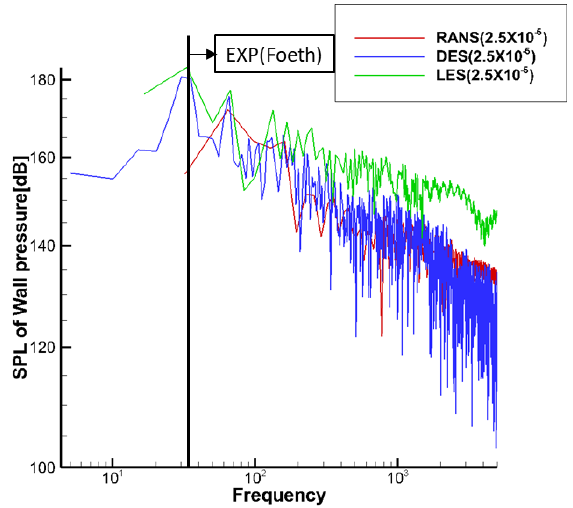
Figure 11. SPL of wall pressure according to turbulence model. Table 9. SPL 1 and SPL of wall pressure using LES model according to time steps and turbulence model at probe 6.